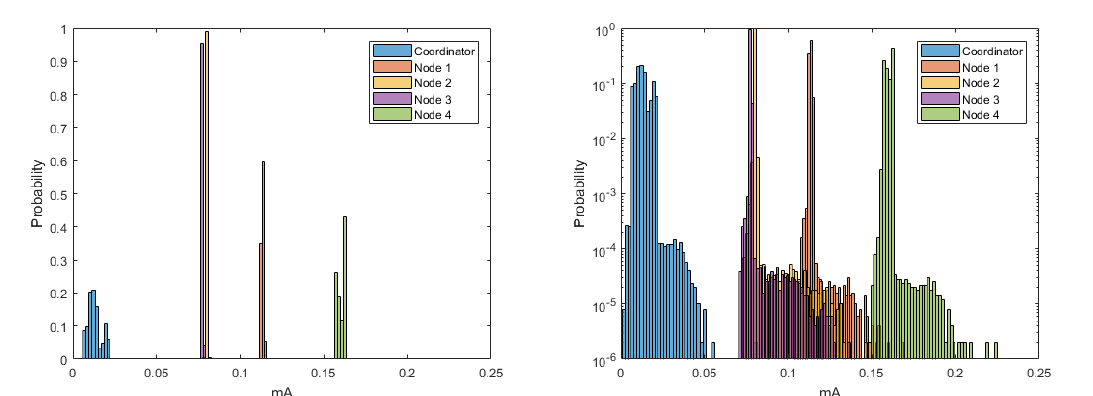
Figure A3. Histograms of the consumption signals for DigiMesh network at 9600 bauds: ( Left ) linear scale; and ( Right ) logarithmic